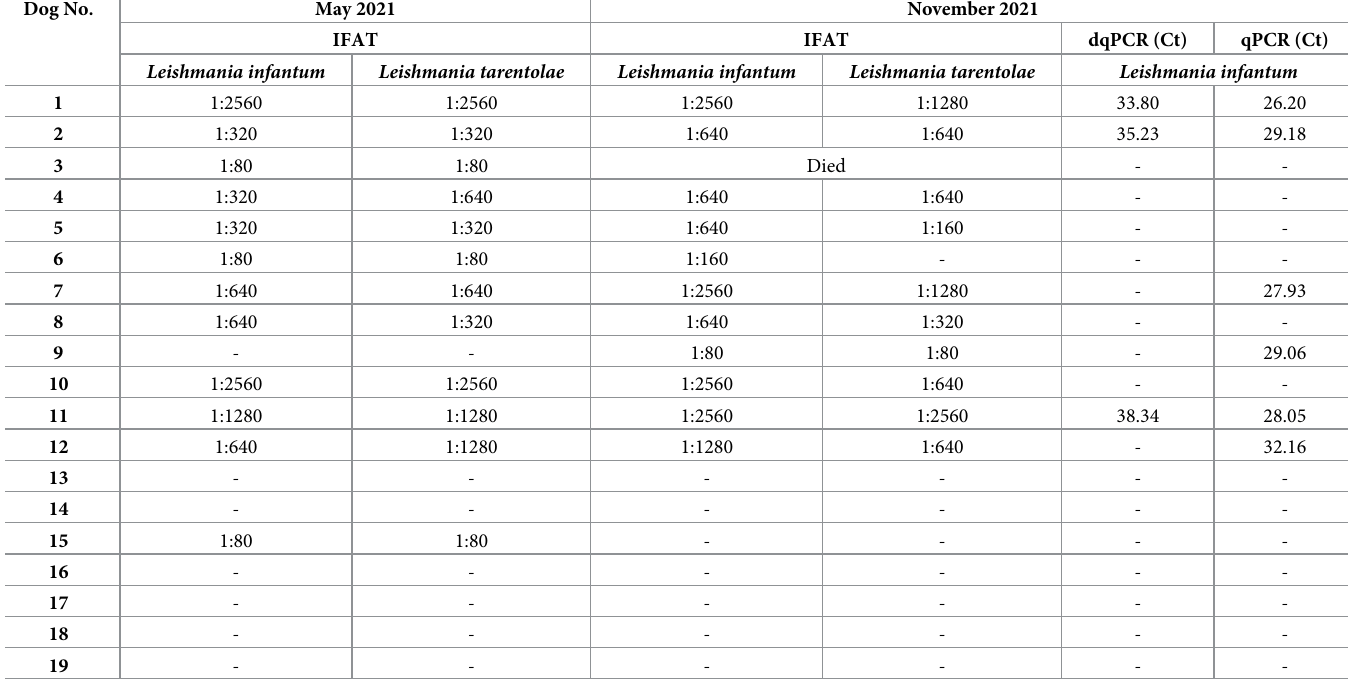
Table 3. Antibody titers against Leishmania infantum and Leishmania tarentolae promastigotes detected by indirect fluorescent antibody test (IFAT) according to sampling time (May and November 2021) and serum dilution (1:80 to 1:2560). Values of the threshold cycle (Ct) are reported for dqPCR and qPCR that were only pos- itive for Leishmania infantum . Dog No.